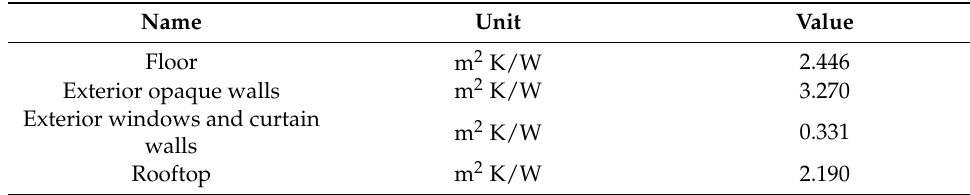
Table 4. Thermal resistance of the building elements [28].